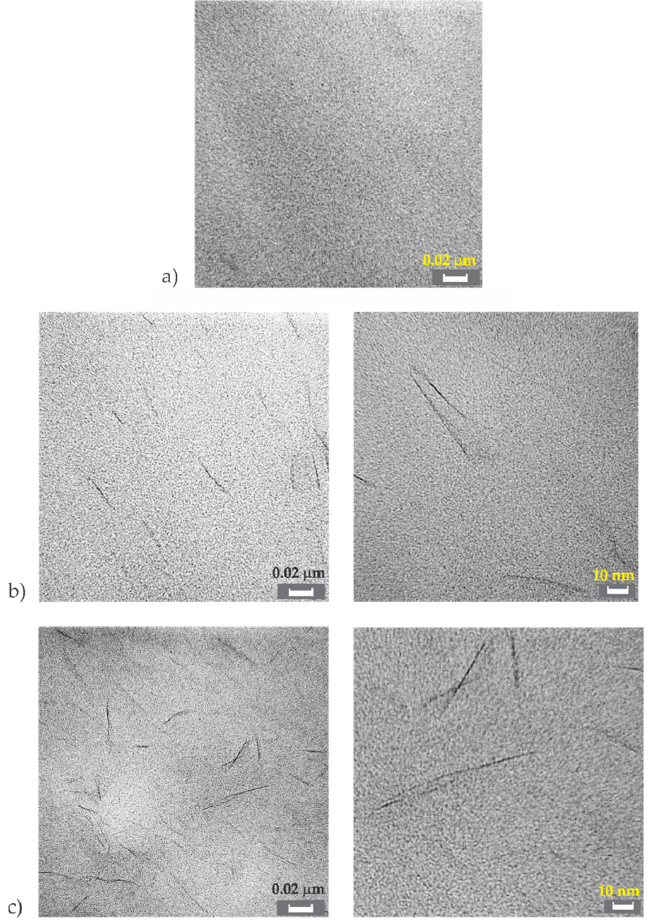
Figure 5. TEM micrographs of ( a ) PA12, ( b ) PA12 nanocomposite with 1% clay and ( c ) PA12 nanocomposite with 3% clay.